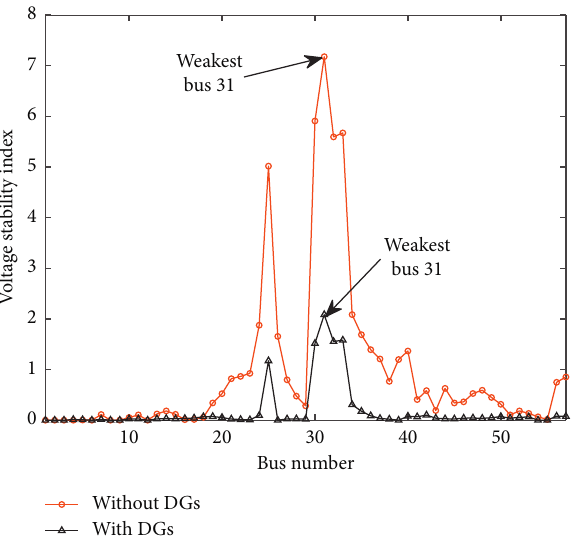
Figure 11: The voltage stability index of 57-bus system when using MCPF without and with DG at buses 26, 39, and